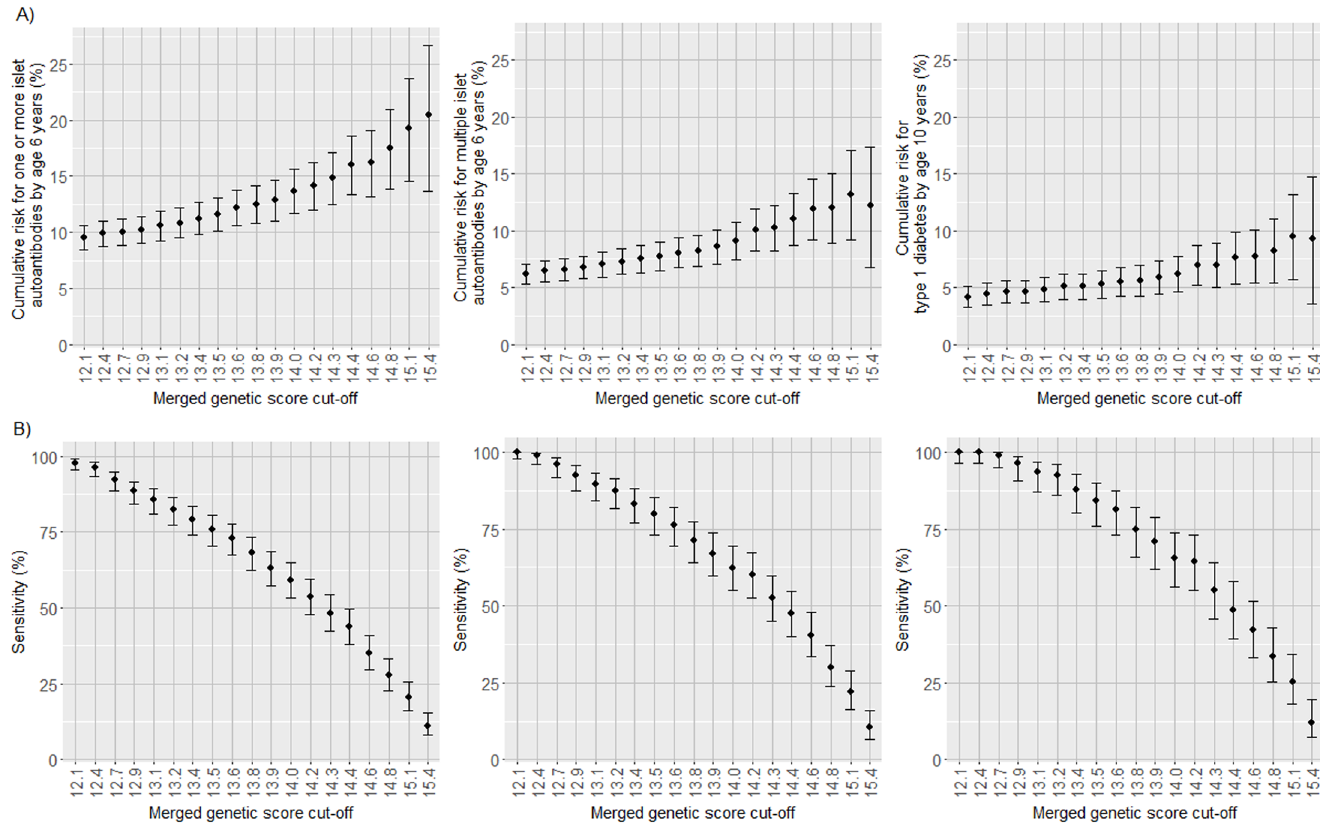
Fig 5. Cumulative risks and the proportion of cases identified for 1 or more islet autoantibodies, multiple islet autoantibodies, and type 1 diabetes in TEDDY children with the HLA DR3/DR4-DQ8 or DR4-DQ8/DR4-DQ8 genotype according to increasing thresholds of the merged genetic score. Cumulative risk for developing islet autoantibodies by age 6 years and diabetes by age 10 years (A) and the proportion of cases positive for islet autoantibodies by age 6 years and diabetes by age 10 years (sensitivity; B) in TEDDY children with the HLA DR3/DR4-DQ8 or DR4-DQ8/DR4-DQ8 genotype stratified by their merged genetic score. The risk and sensitivity are shown for each increment in the genetic score by the 5th percentile of scores in the TEDDY children, ranging from > 12.1 (the 5th percentile of children) to > 15.4 (the 95th percentile of children). The risk and sensitivity are shown for the development of 1 or more islet autoantibodies (left panels), multiple islet autoantibodies (middle panels), and type 1 diabetes (right panels). Error bars indicate 95% confidence intervals.